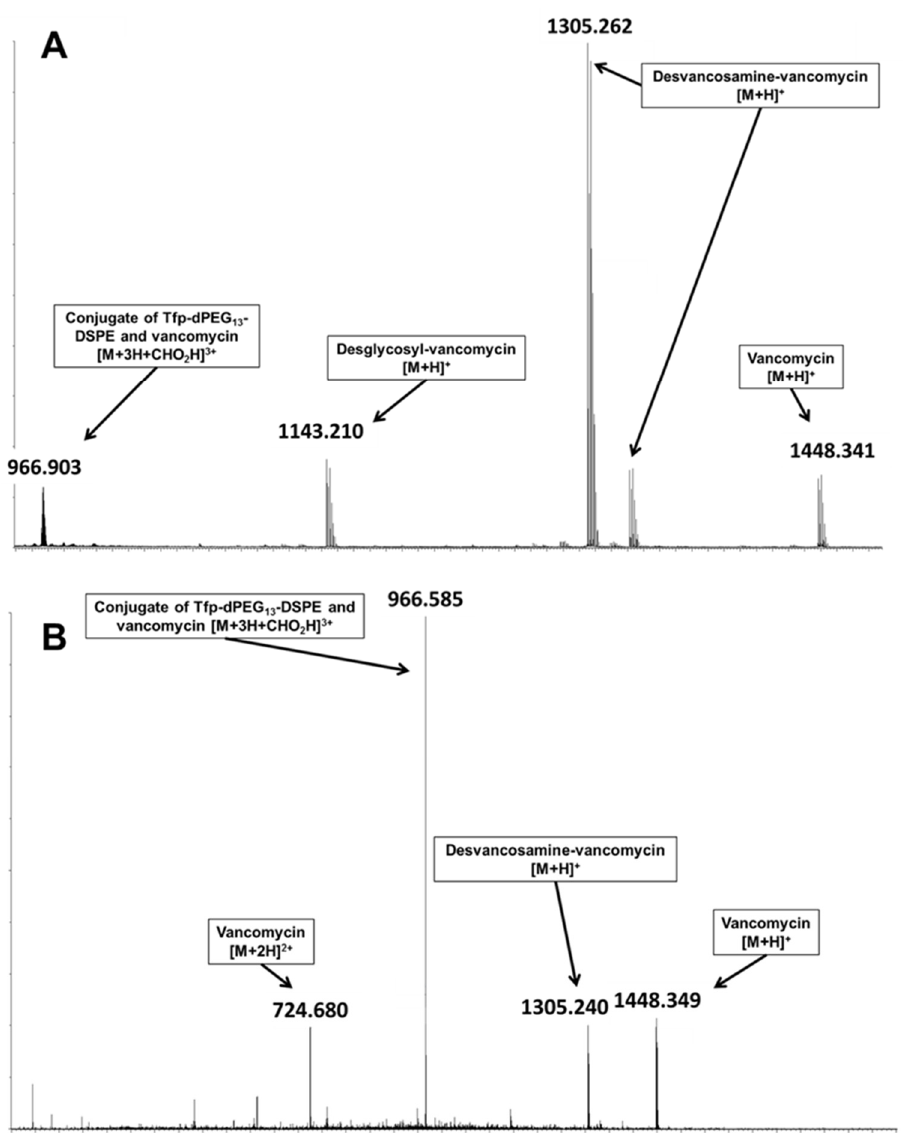
Figure 2. High-resolution mass spectrometric characterization of liposomes comprising Tfp-dPEG 13 - DSPE and encapsulated vancomycin. ( A ) Mass spectrum of vancomycin-containing liposomes comprising Tfp-dPEG 13 -DSPE. Visible is the formic acid mono-adduct of the conjugate of Tfp-dPEG 13 - DSPE and vancomycin ([M+3H+CHO 2 H] 3+ ), while the remaining signals correspond to unmodified vancomycin with three being in-source fragments (desglycosyl-vancomycin, desvancosamine- vancomycin, and its corresponding sodium adduct). ( B ) Positive product spectrum of the [M+3H+CHO 2 H] 3+ signal of the conjugate of Tfp-dPEG 13 -DSPE and vancomycin after collision- induced dissociation (CID) at 30 V. Besides the parent signal, the primary CID fragments are ions corresponding to vancomycin confirming the conjugates identity.